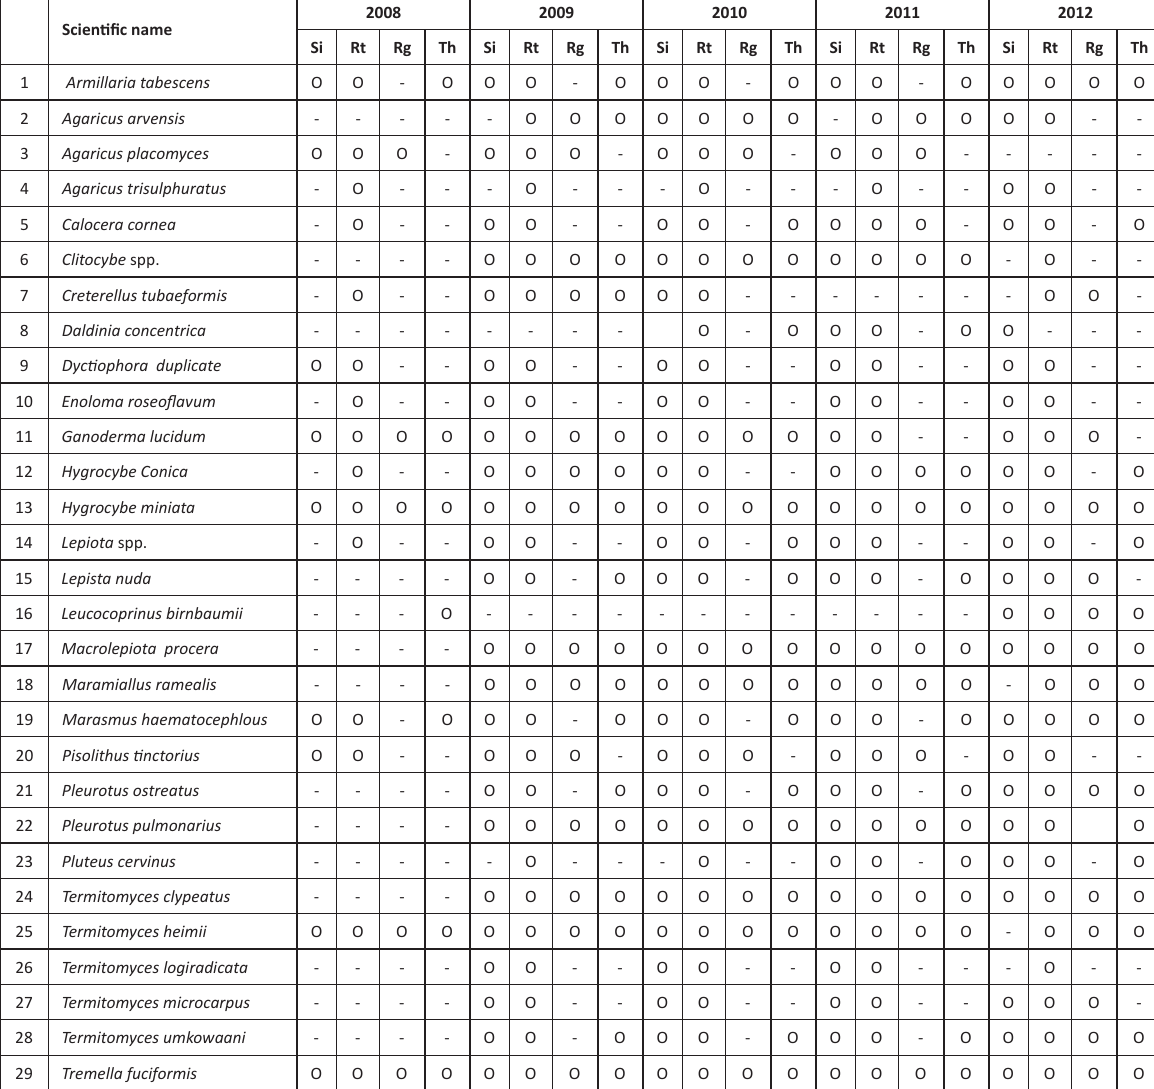
Table 1. Occurrence of naturally growing mushroom flora in four districts of Konkan